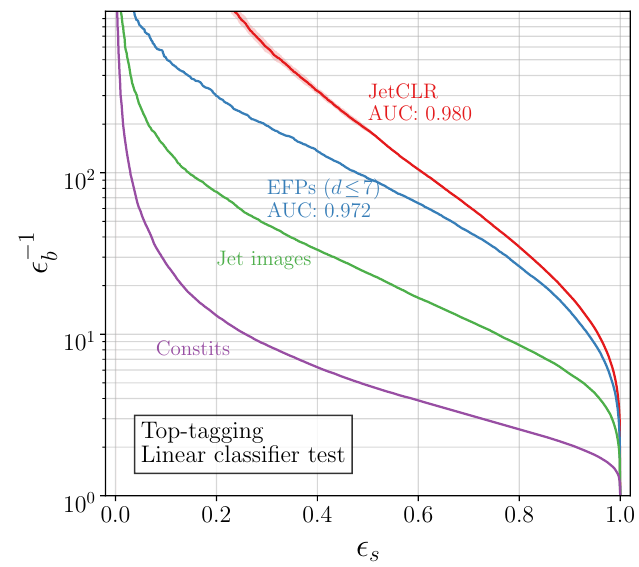
Figure 6: Comparison of JetCLR with other classification